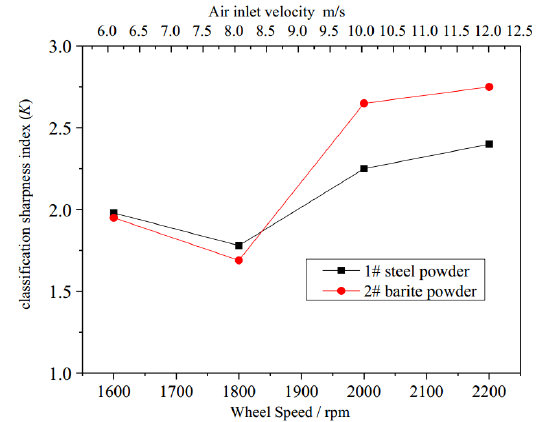
Figure 9. E ff ects of four process parameters on the classification sharpness index (K). Figure 9. Effects of four process parameters on the classification sharpness index (K).